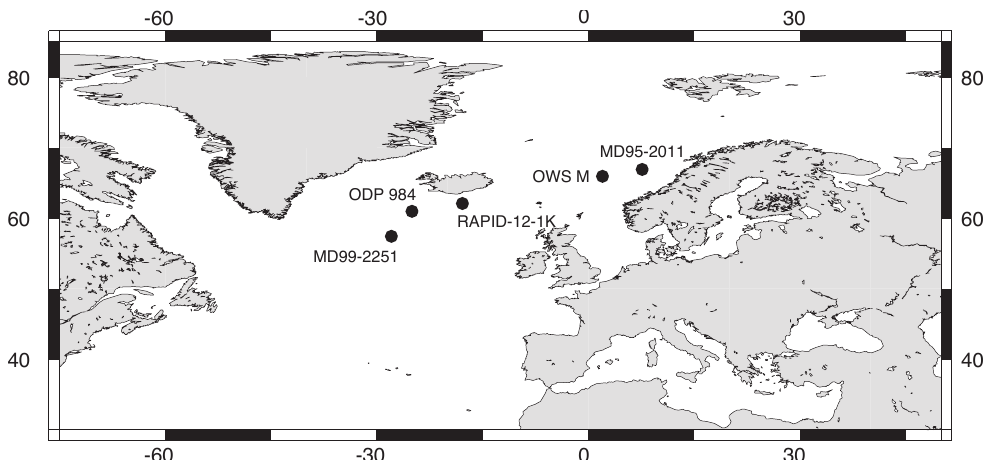
Fig. 1. Map showing the location of cores MD95-2011, MD99-2251, ODP 984 and RAPiD-12-1K. The position of Ocean Weather Station (OWS) Mike is also